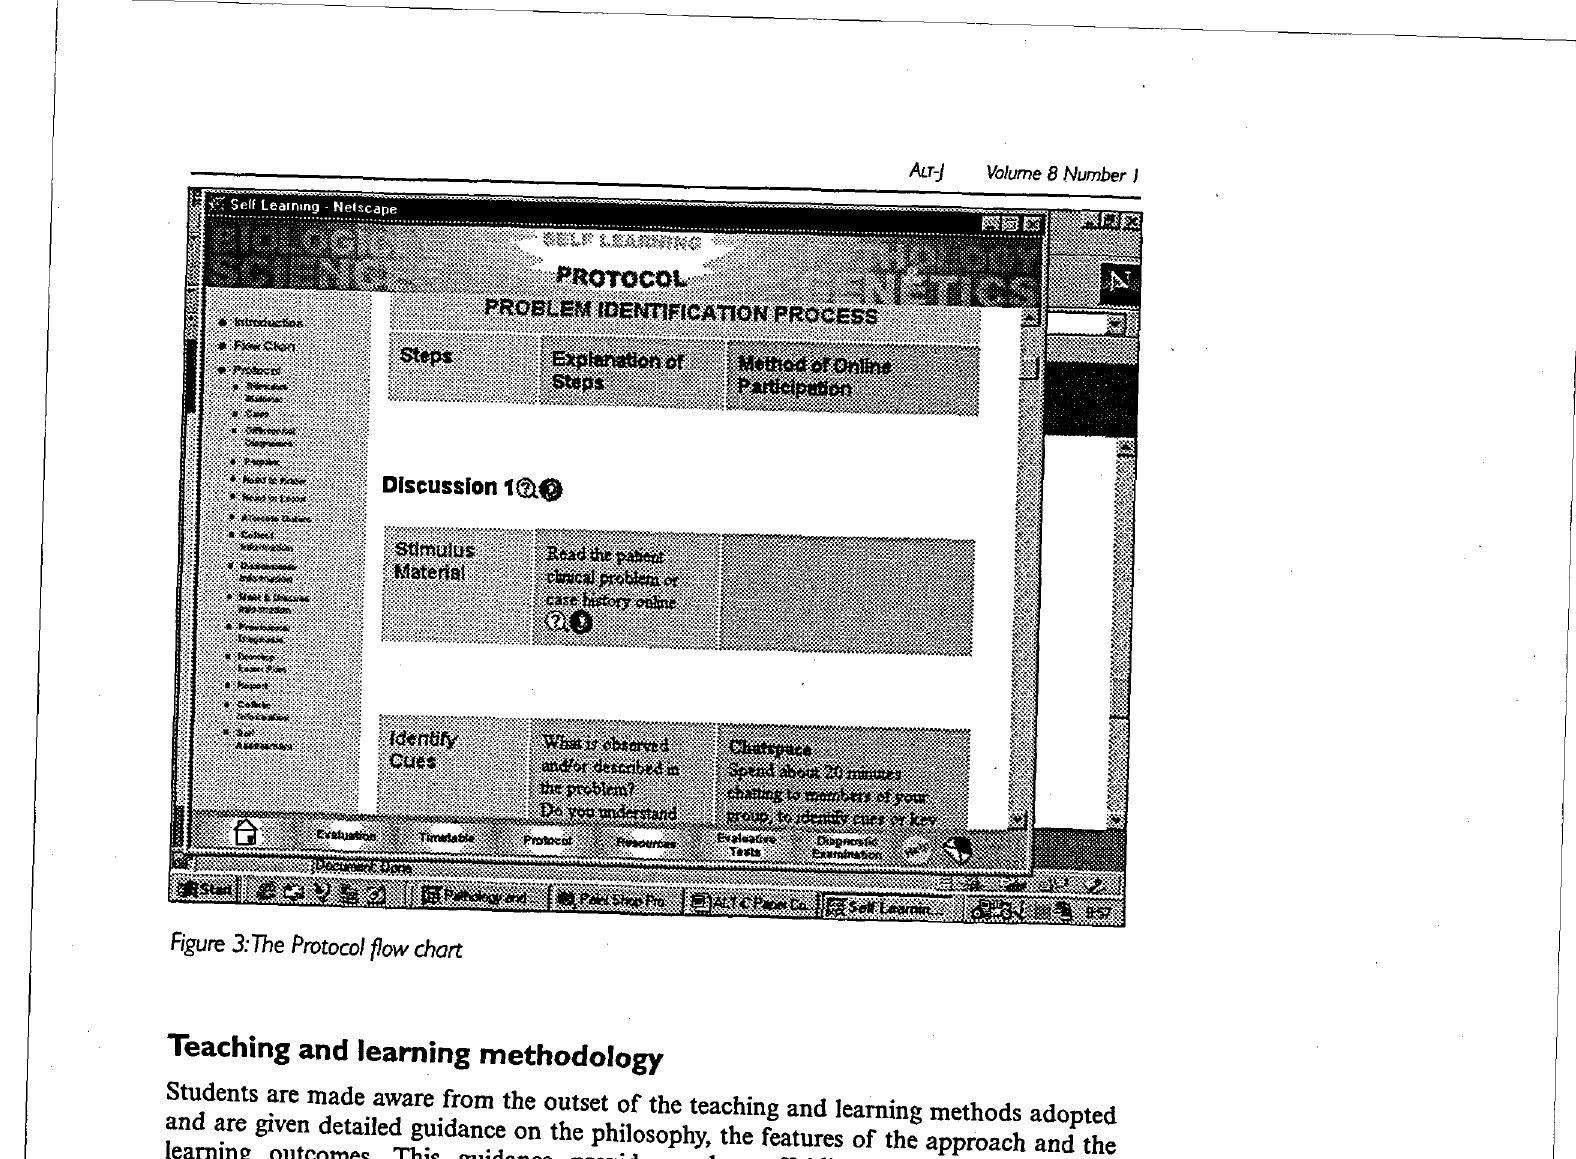
of the teaching